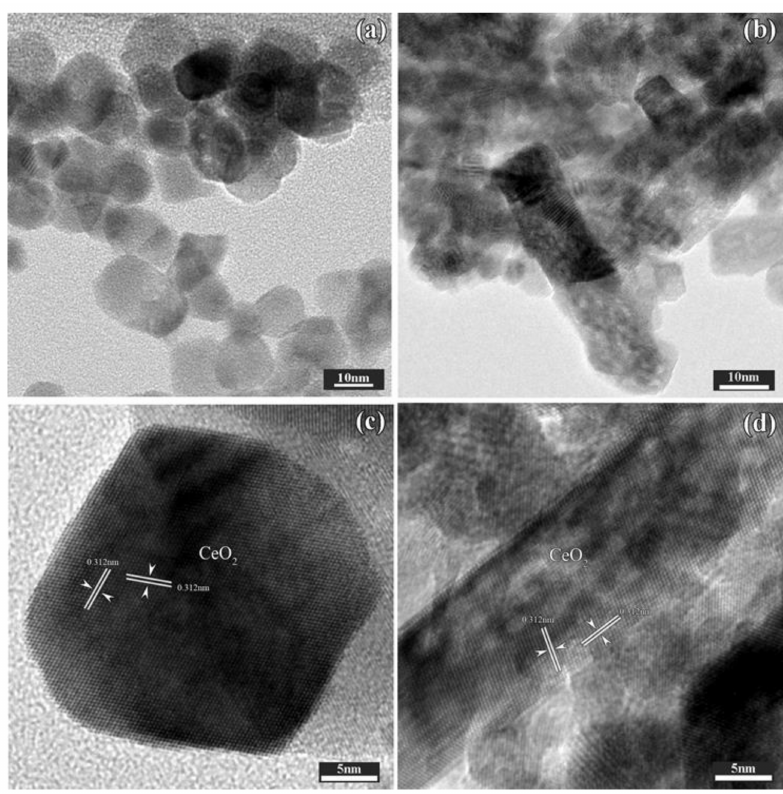
Figure 2. Low magnification images (overview) of the CeO 2 specimens, synthesized using the precipitation, CeO 2 -P ( a ) or the hydrothermal CeO 2 -H ( b ) method. The corresponding HR-TEM micrographs of the CeO 2 -P sample ( c ), and the CeO 2 -H sample ( d ), respectively.